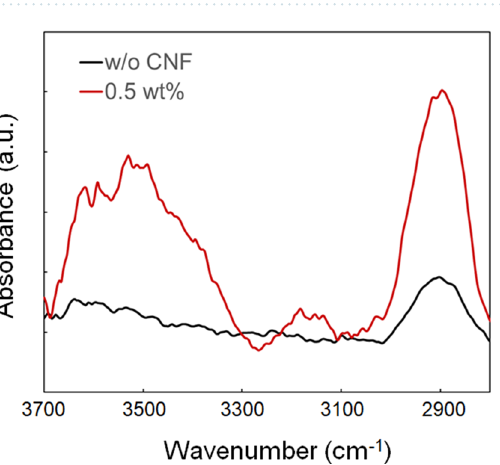
Figure 3. ( a ) Optical microscope images of the fabricated microstructure with different numbers of laser scans. The scale bar indicates 10 µm. ( b ) Dependence of line width of the fabricated microstructure on the number of laser scans. The laser power and scanning speed were 20 mW and 125 µm/s, respectively. The line widths of the fabricated microstructures were measured at five locations, and the average value was plotted with the standard error.